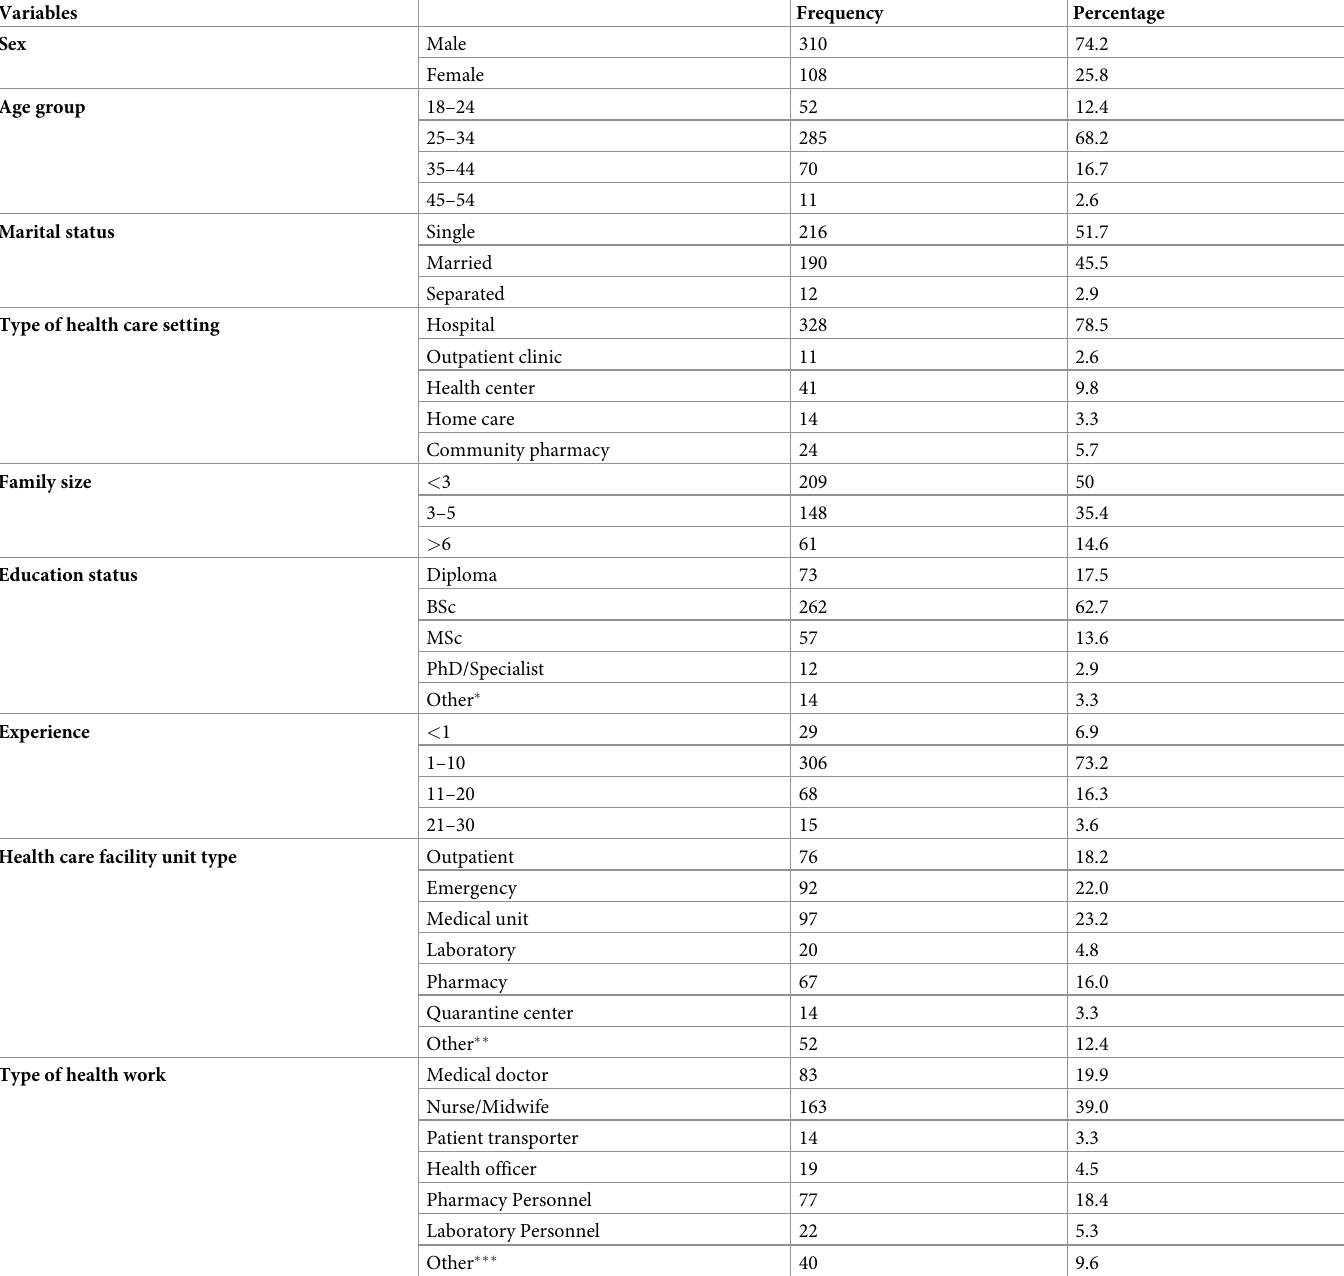
Table 1. Socio-demographic characteristics of health workers in the Amhara region, 2020 (N =